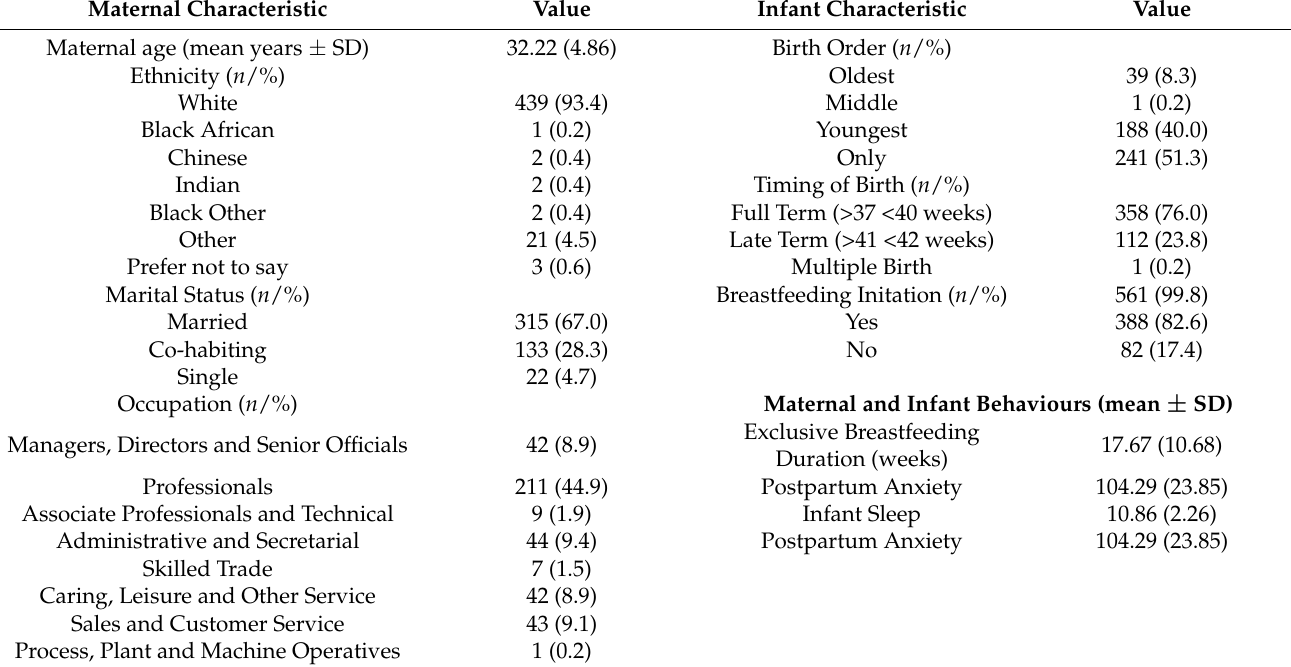
Table 1. Maternal and Infant Demographics ( n =